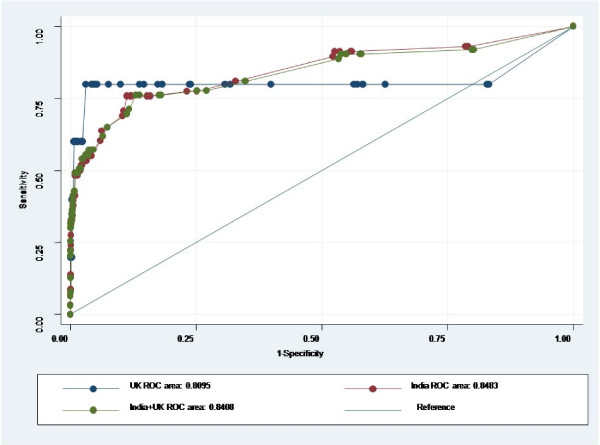
Areas under ROC curves.